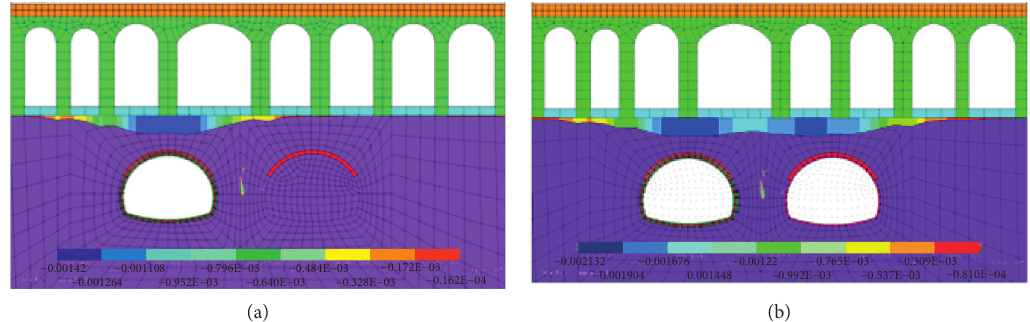
Figure 9: Settlement of aqueduct foundation. (a) After the excavation of the left tunnel. (b) After the excavation of the right tunnel.